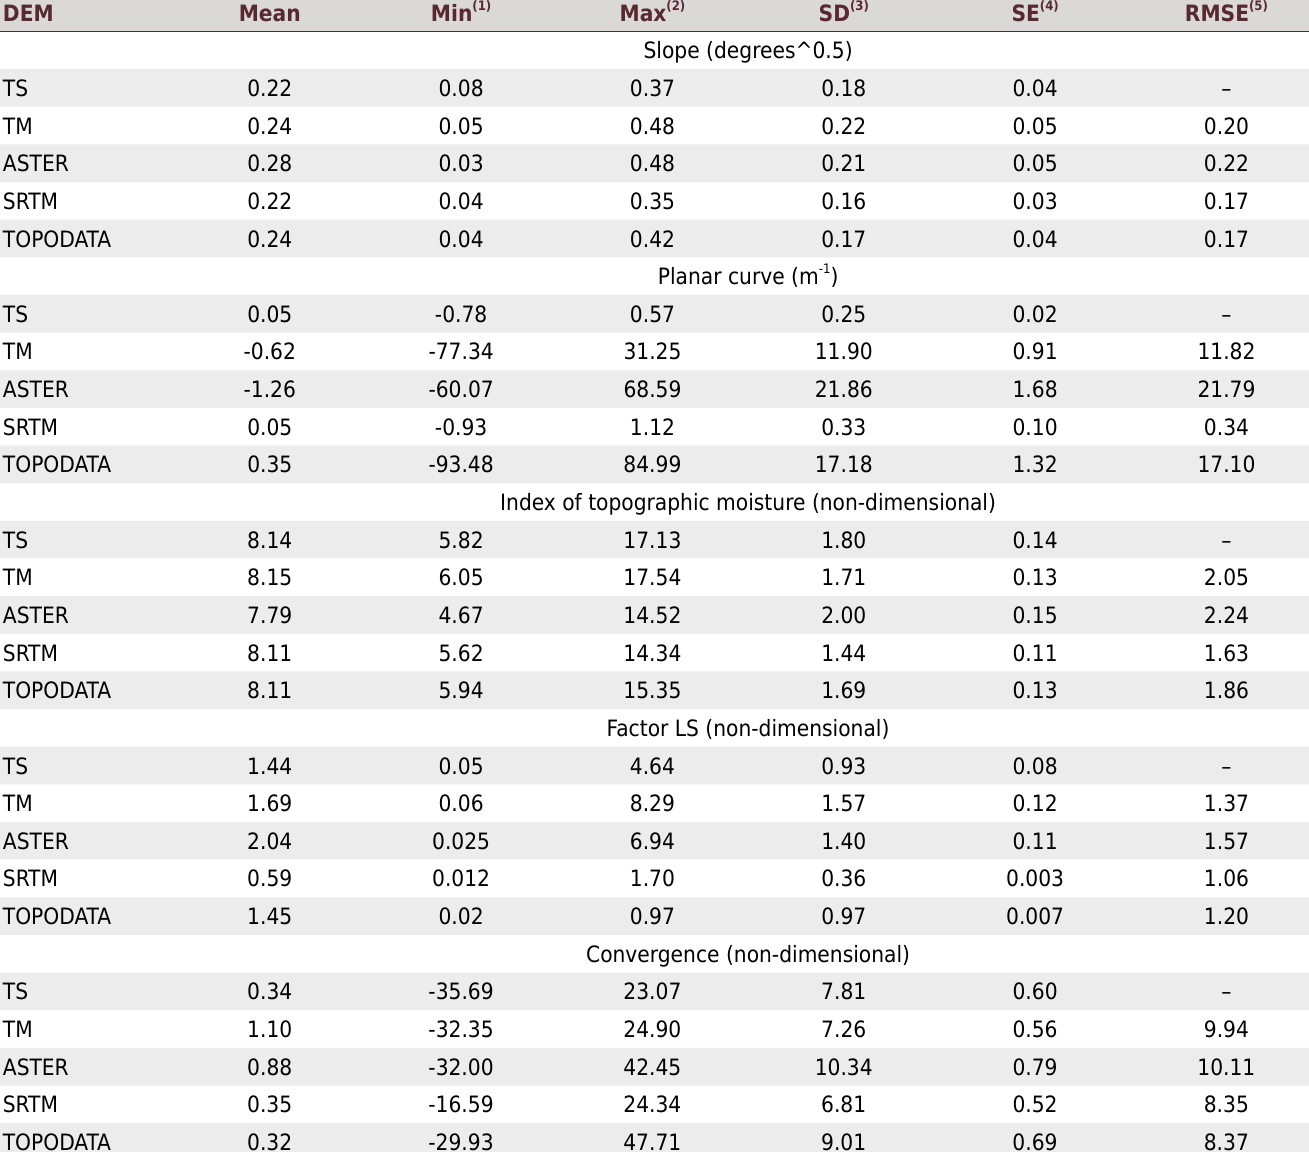
Table 3. Descriptive statistics of the results of terrain attributes (TA) derived from each DEM